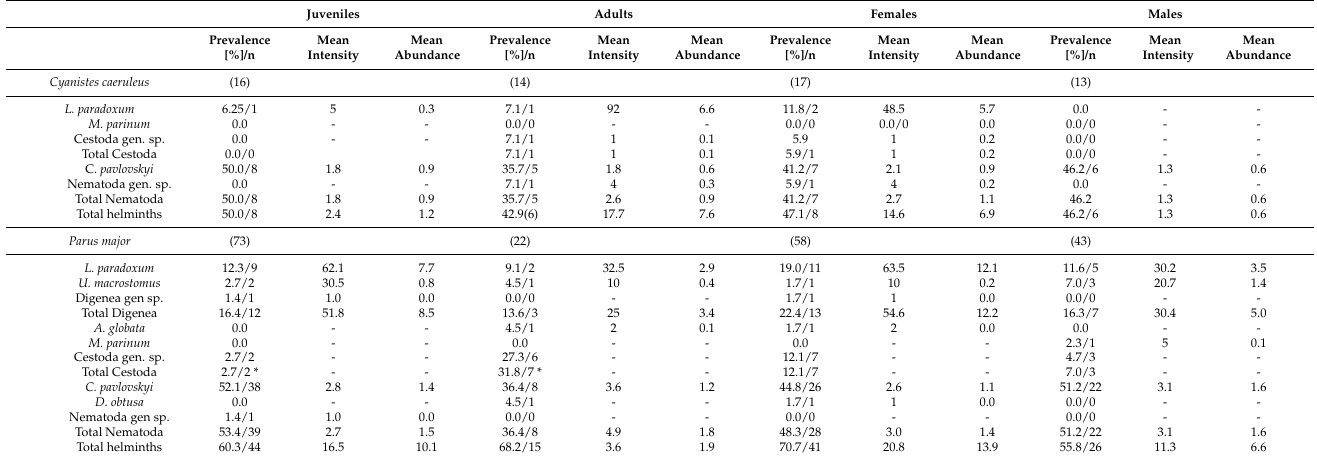
Table 3. Occurrence of helminths in juvenile and adult tits and in female and male tits. Numbers of examined juveniles and adults and females and males are given in brackets.